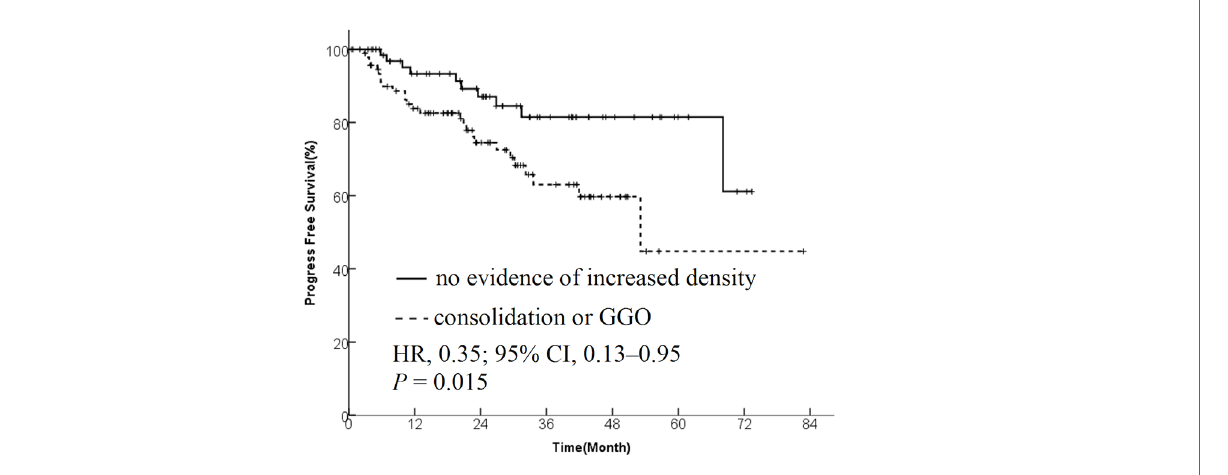
FIGURE 2 | Kaplan – Meier curves for progression-free